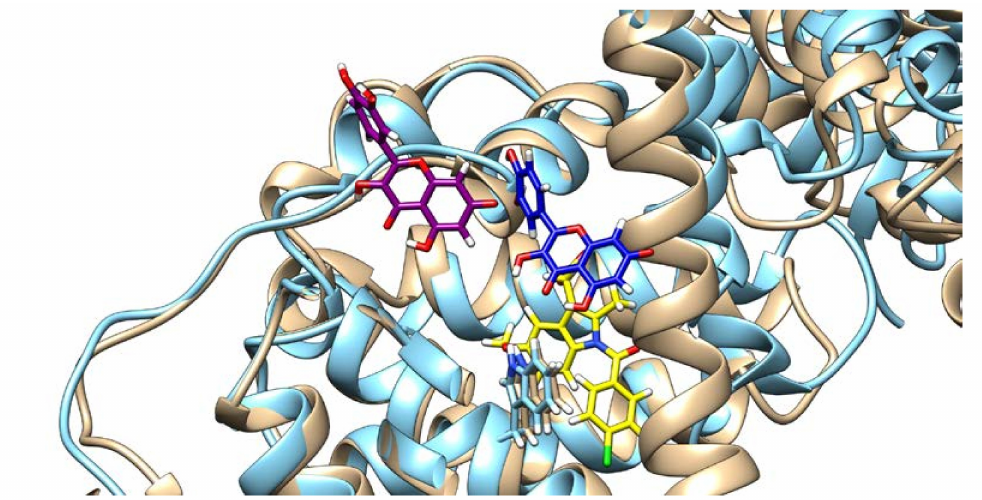
Figure 6. Quercetin poses and HSA conformation in the absence (quercetin is depicted in purple and HSA in brown) and in the presence of indomethacin (quercetin is depicted in blue, HSA in light blue, and indomethacin in yellow), with the Trp214